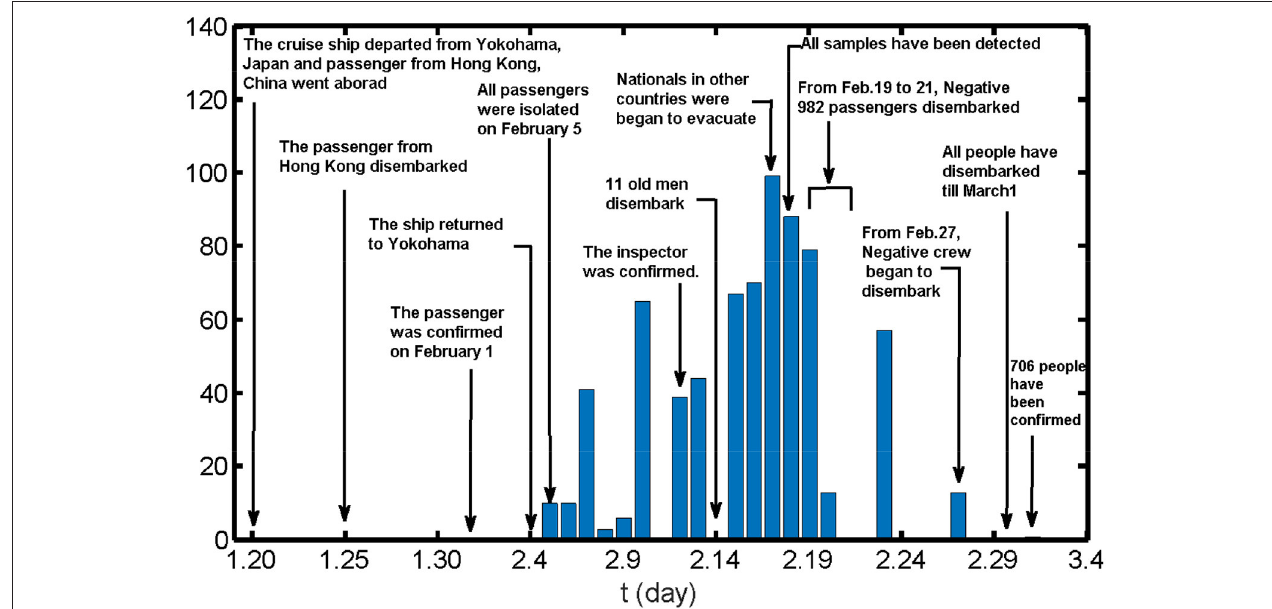
FIGURE 1 | The course of development of the COVID-19 epidemic on the Diamond Princess cruise